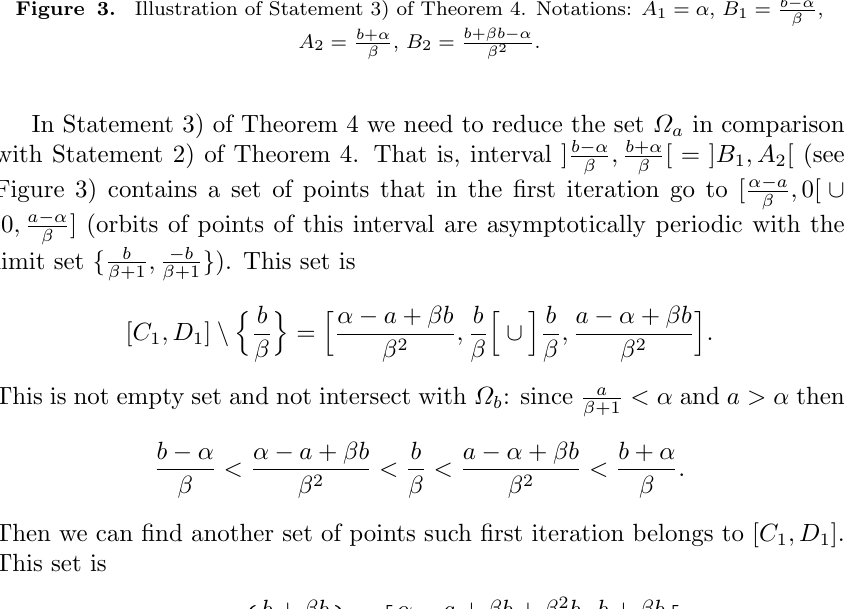
Figure 3. Illustration of Statement 3) of Theorem 4. Notations: A 1 = α , B 1 = b − α